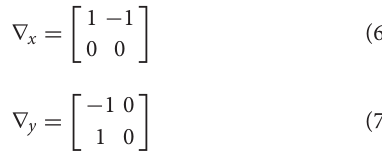
Algorithm 2 – 3D Triangulation